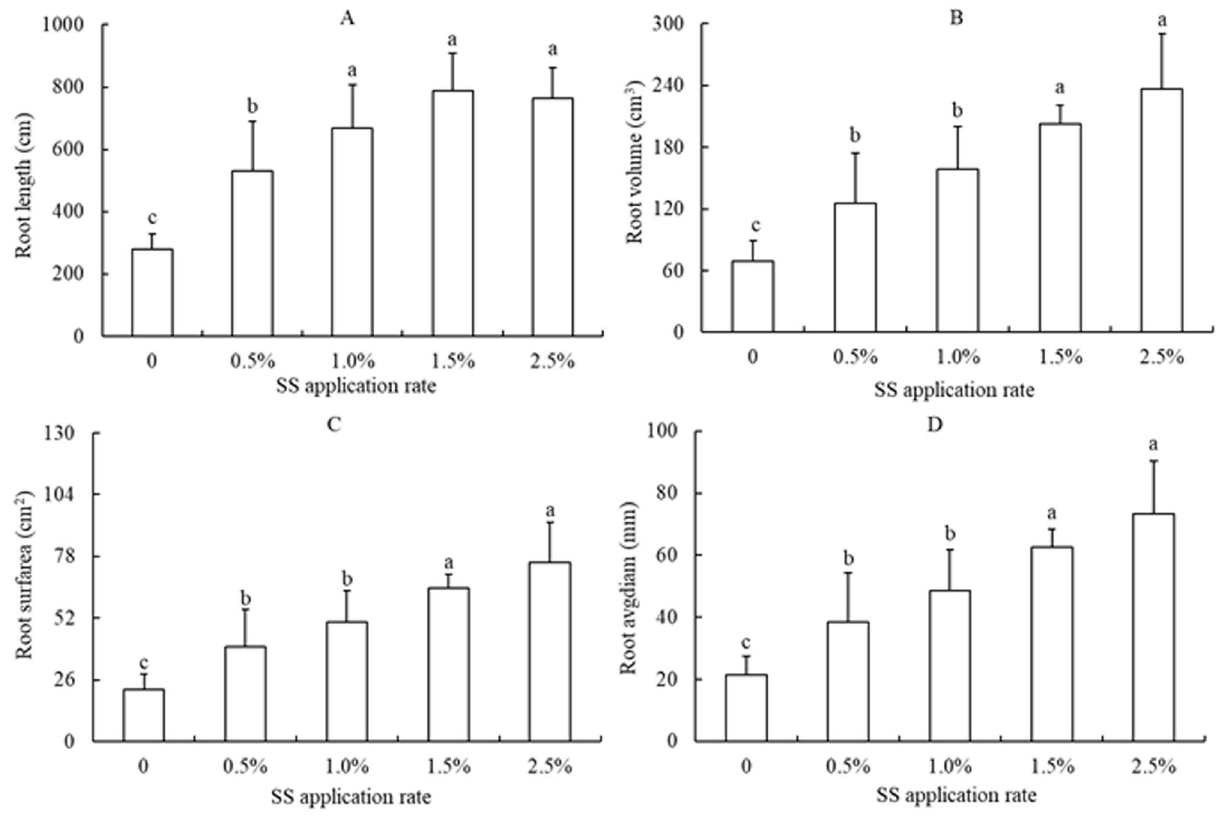
Figure 2. Effects of sewage sludge (SS) application on root length ( A ), root volume ( B ), root surface area ( C ) and root diameter ( D ) of rice plants at tillering stage in salt-affected mudflat soil. Columns with different letters show significant difference between SS application rates at p < 0.05 by LSD’s multiple range test.